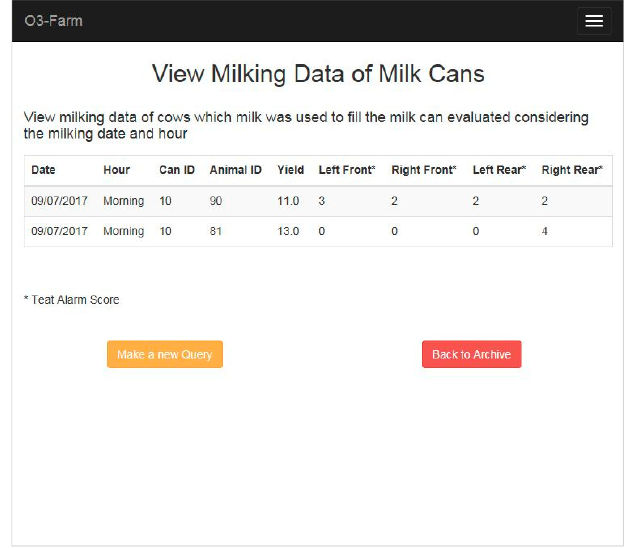
Figure 8. Example of a set of milking data of the group of cows that have filled a specific can of milk.